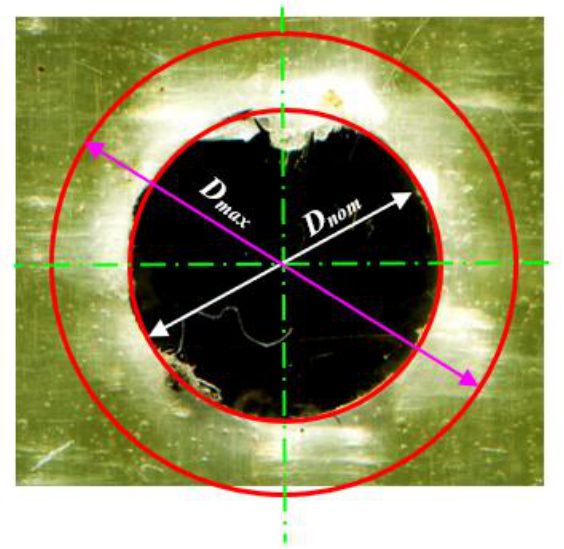
Figure 3. Push-out delamination in drilling GFRP composites at 400 rpm and 0.05 mm/r.